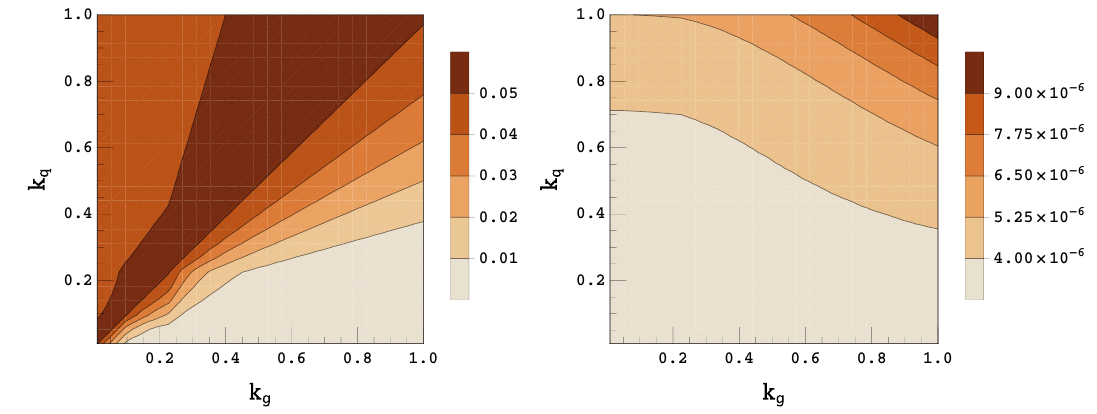
Figure 3 . The contour plot of couplings k q and k g for signal at NNLO+NNLL with a fixed value of the spin-2 mass M 1 = 1 TeV. The left plot shows the cross-section (in pb ) at the resonance Q = M 1 , the right plot shows the cross-section (in pb ) away from the resonance at Q = 1 . 5